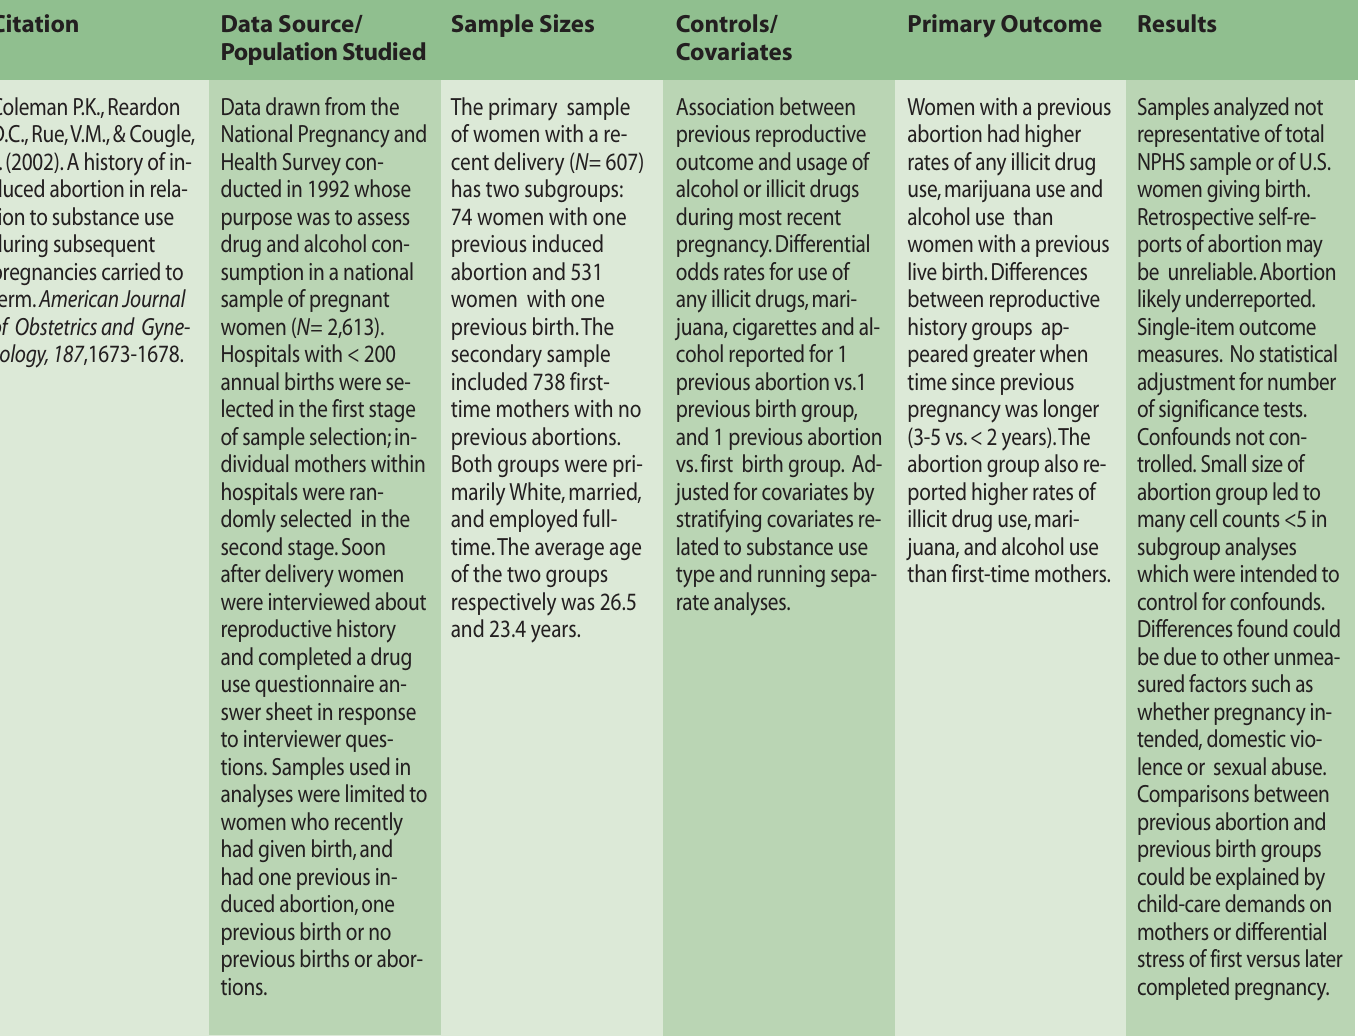
Table 1B: Secondary Analyses of Survey Data–Abortion vs.Comparison